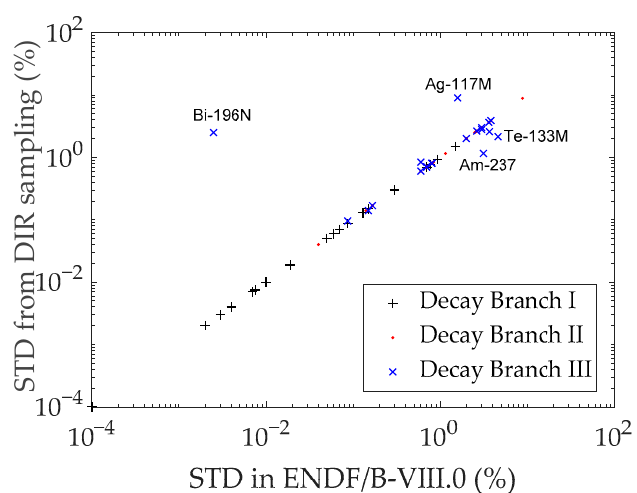
Figure 8. Comparison between suggested STDs in ENDF/B-VIII.0 and estimated STDs from DIR sampling method. (Black “+”, red “.”, and blue “×” are decay branches I, II, and III, respectively; STD means standard deviation; Outliers are observed in the estimated branch ratio STD of branch III in Bi-196N, Ag-117M, Te-133M, and Am-237.).